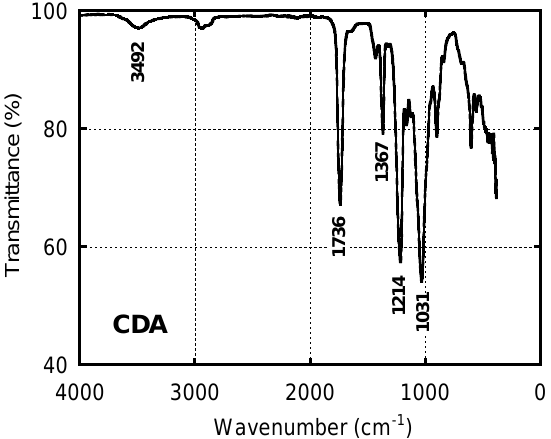
Figure 7. ATR-FTIR spectrum of CDA exposed to 0% humidity of ambience.